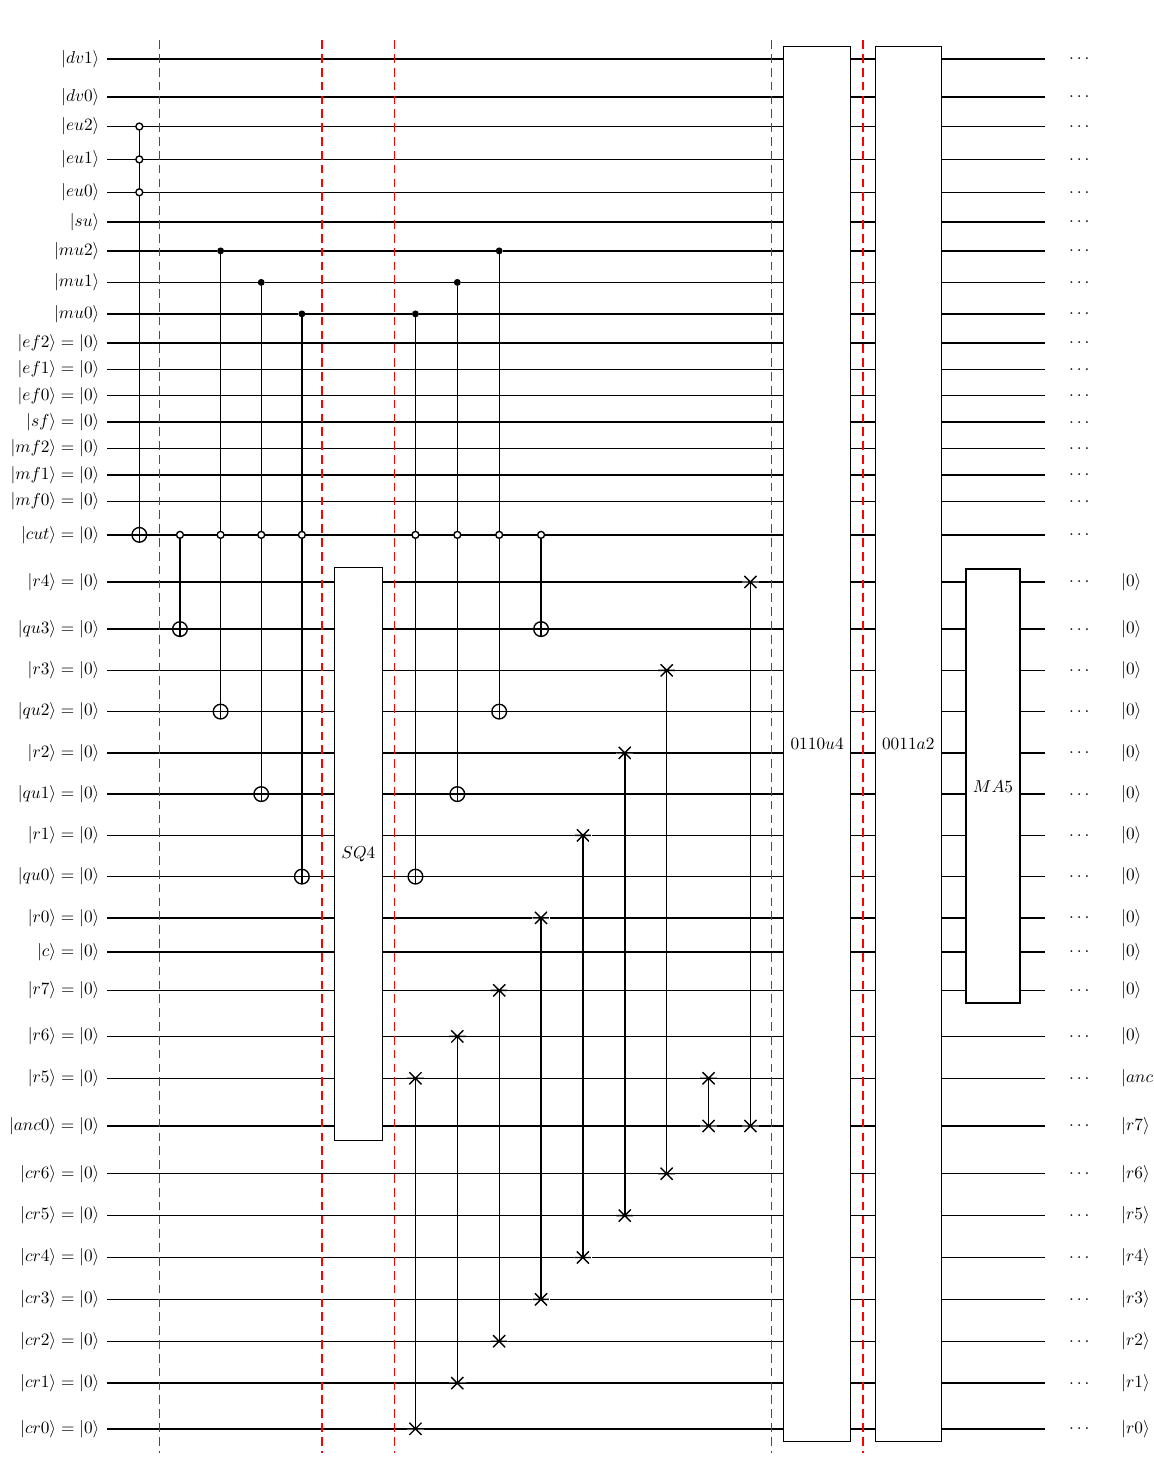
Figure 6. Quasi-1D Burgers: quantum circuit design for computing (cid:126) f eq in the lattice model. The floating-point representation uses four mantissa qubits ( N M = 4) and three exponent qubits ( N E = 3), with an exponent bias set to five. Part